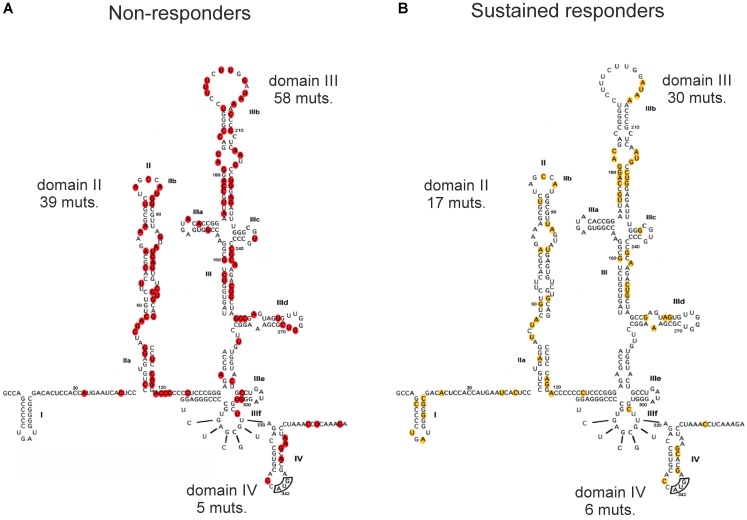
Distribution of mutations across the HCV IRES from patient samples with respect to sustained response and no antiviral response to HCV treatment. (A) Sustained responders (SRs), localization of 53 individual mutations found in the literature. (B) Non-responders (NRs), localization of 102 individual mutations found in the literature (Yamamoto et al., 1997; Lu et al., 1999; Saiz et al., 1999; Soler et al., 2002; Thelu et al., 2004; Yasmeen et al., 2006; Ogata et al., 2008; El Awady et al., 2009). Total numbers of mutations (muts.) found within the corresponding domains in the SR and NR groups are depicted.